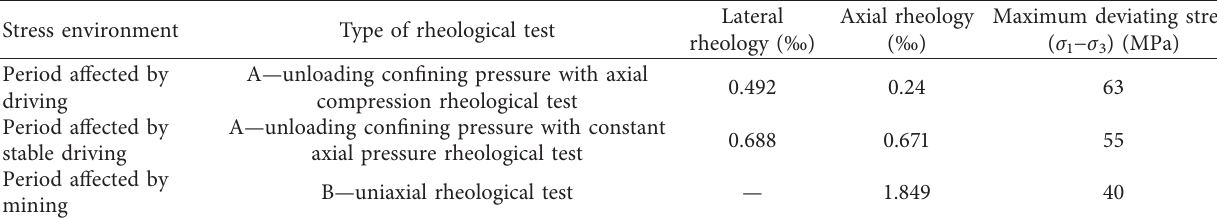
Figure 12: Variation curves of mudstone rheology with deviating stress. (a) Rheological strains of mudstone in triaxial rheological test. (b) Rheological strain of mudstone in uniaxial rheological test. Table 8: Rheological strains of mudstone rheological test